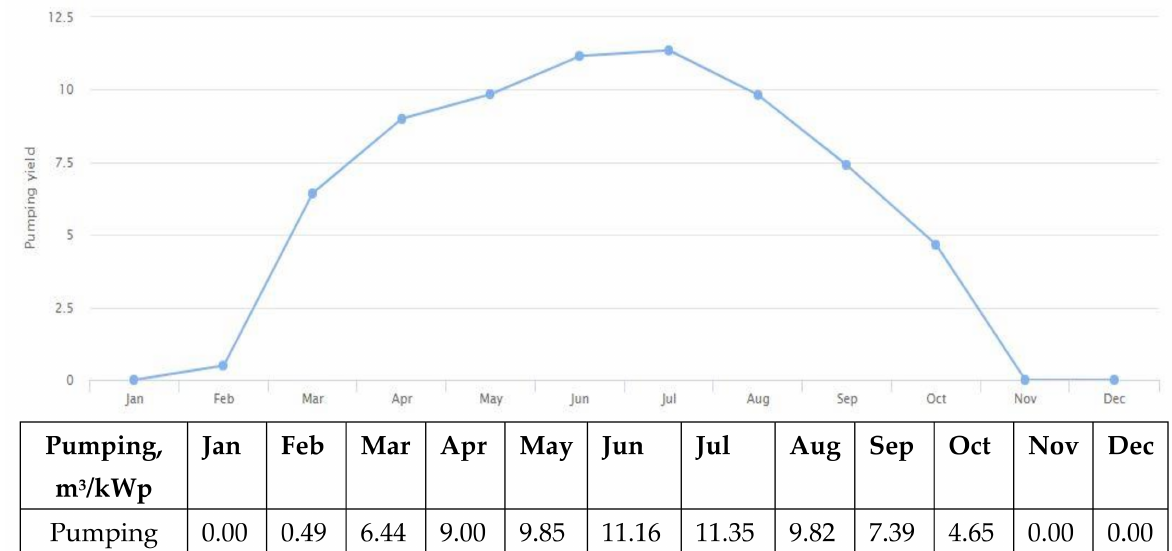
Figure 11. Monthly pumping yield of the PV pumping system (a specific site, South of Romania).